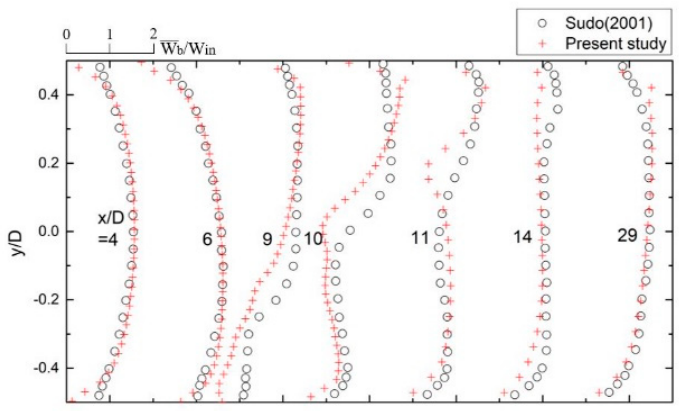
Figure 6. Distribution of streamwise mean velocity.